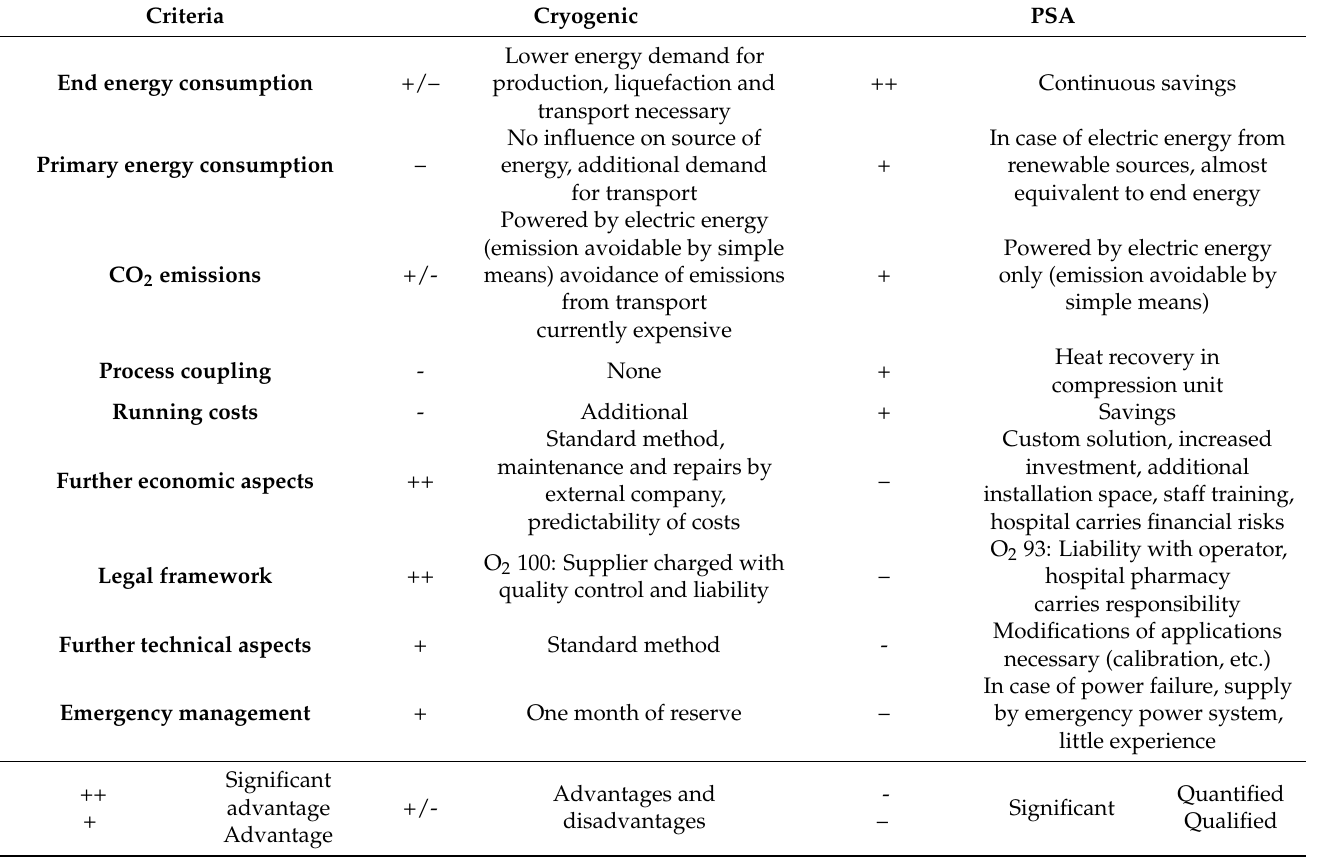
Table 8. Comparison of options for medical oxygen